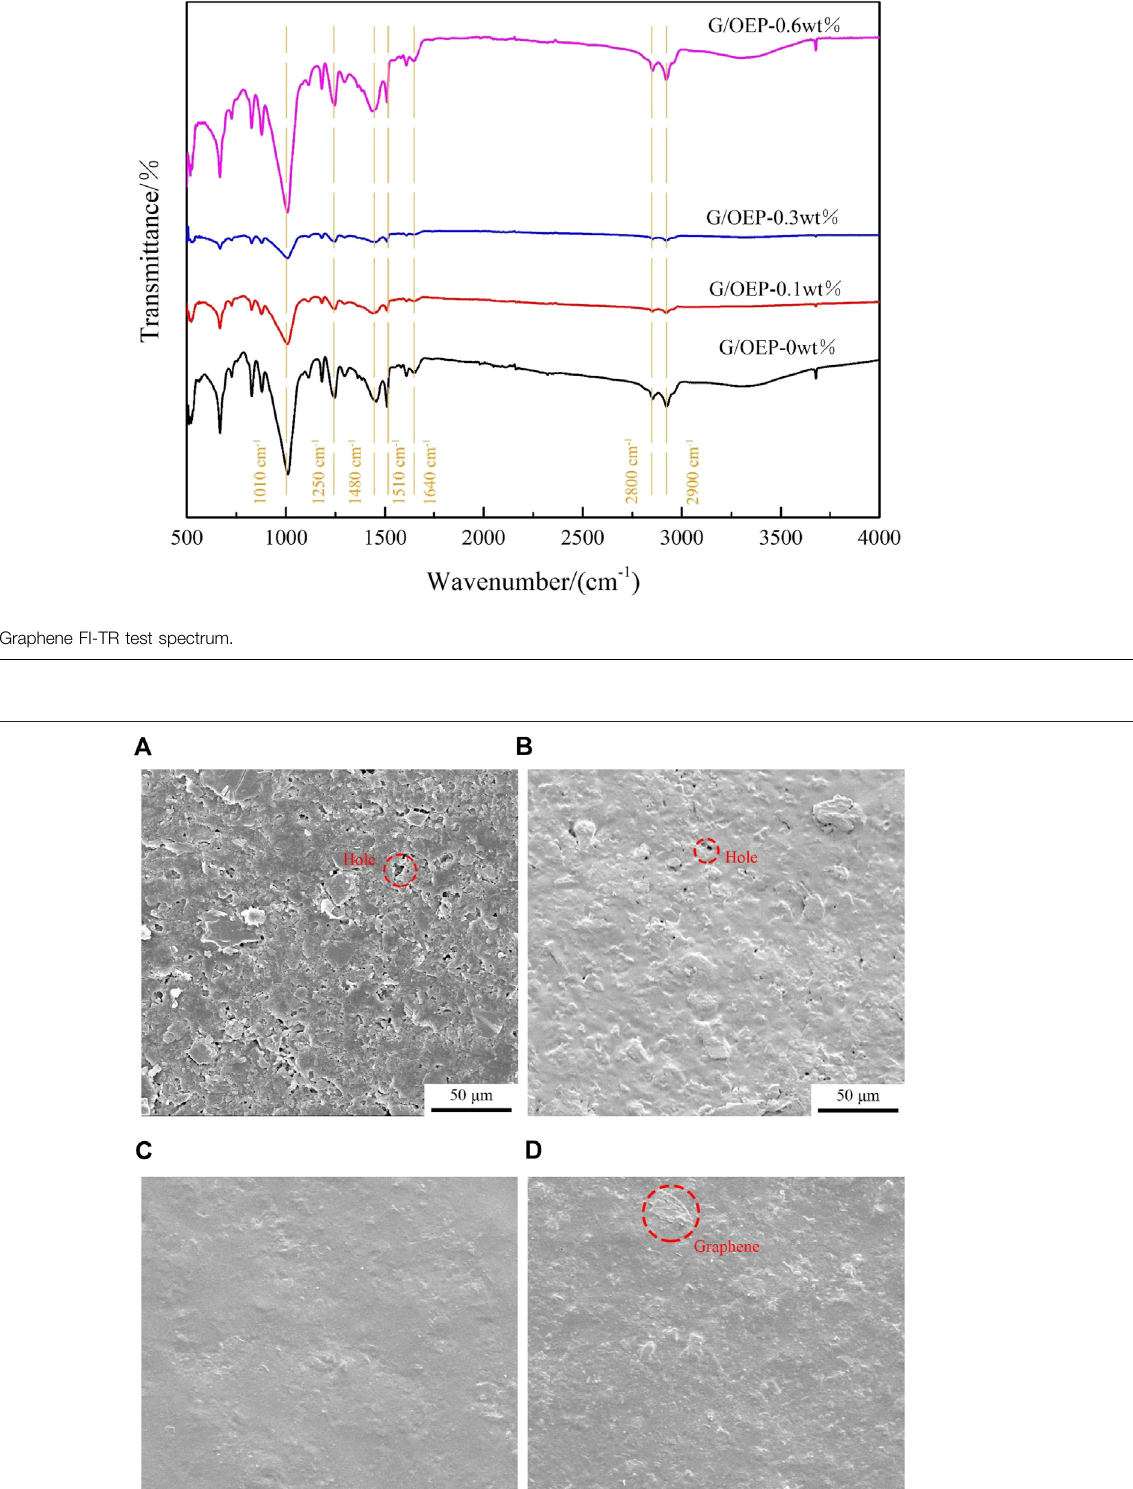
Frontiers in Materials |